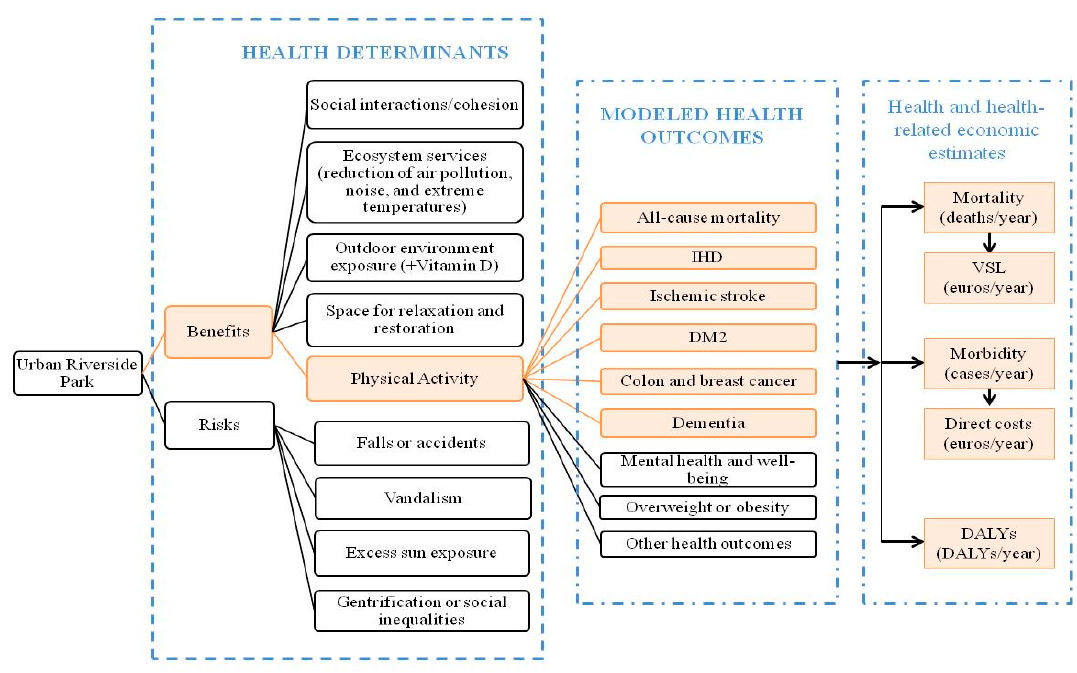
Figure 3. Pathways modeled (in orange) and non-modeled (in black) related to health impacts derived of the urban riverside park. IHD: ischemic heart disease; DM2: diabetes mellitus type 2; VSL: value of statistical life; DALYs: Disability Adjusted Life Years.